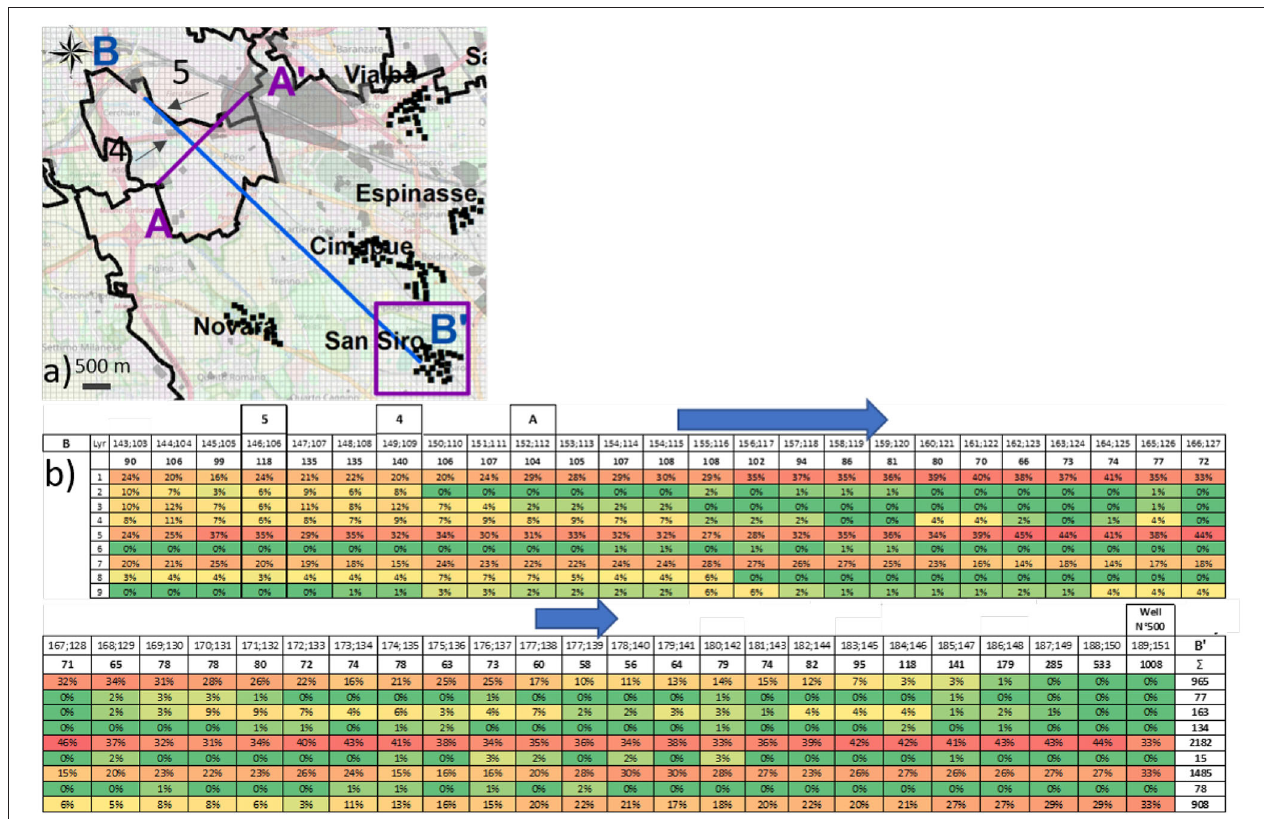
FIGURE 8 | (a) Cross-section B, oriented NW-SE (BB’) with the blue arrow indicating the flow direction: line one shows the cell coordinates, line two shows the sum of particles passing in each vertical column and then the percentage for each layer, and the last column represents the number of particles for each layer; (b) zoom of Figure 7 , showing the area and two different industrial sites (4 and 5). The hydrogeological cross-section is shown in the Supplementary Figure 6B